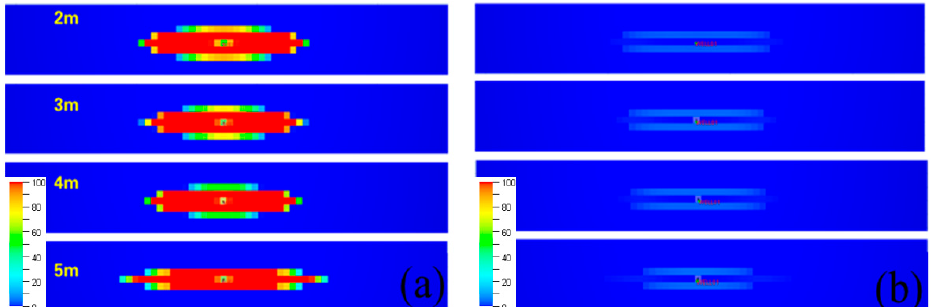
Figure 14. Planar fracture permeability distribution with different payzone thickness values. ( a ) After fracturing; ( b ) after 6 years of production.